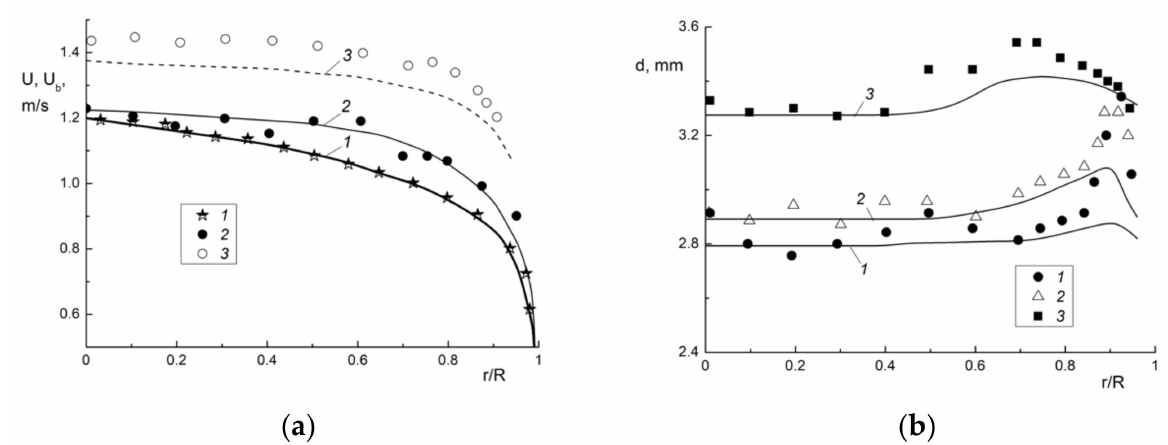
Figure 5. Radial profiles of the carrier fluid and gas bubbles ( a ) and mean Sauter gas bubbles diameters ( b ). β = 4.6%, Re = U m 1 2 R / ν = 4.9 × 10 4 , x /(2 R ) = 53.5, 2 R = 50.8 mm, U m 1 = 0.986 m/s, d 1 = 2.4 mm. Symbols are the measurements of [38], curves are the authors predictions. ( a ): 1, 2 are the carrier fluid axial velocities in the single-phase and two-phase bubbly flows respectively; 3 is the gas bubbles axial velocity. ( b ): 1— J b = 0.0473 m/s, β = 4.6%, d 1 = 2.4 mm; 2—0.113 m/s, 10.3%, 2.5 mm; 3—0.242 m/s, 19.7%, 2.8